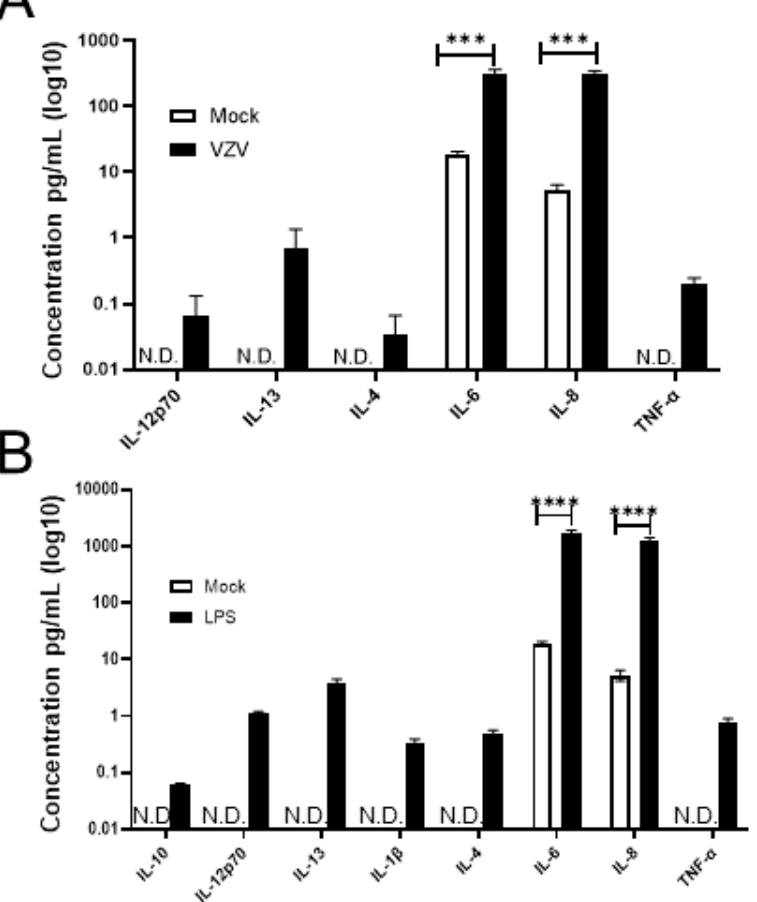
Figure 3. VZV-infected quiescent human adrenal cortical cells (qHAdCCs) secrete proinflammatory cytokines. ( A ) At 3 days post-infection, conditioned supernatant from mock- and VZV-infected cells were analyzed for proinflammatory cytokines IL-1 β , IL-2, IL-4, IL-6, IL-8, IL-10, IL12p70, IL-13, IFN- γ , and TNF- α by a multiplex assay. Compared to mock-infected cells, VZV-infected cells had significantly increased levels of IL-6 ( p = 0.0005) and IL-8 ( p = 0.0002). IL-12p70, IL-13, IL-4, and TNF- α were detected in supernatant from VZV-infected cells, but not from mock-infected cells. ( B ) As a positive control to demonstrate that qHAdCCs have the capacity to secrete proinflammatory cytokines, qHAdCCs were treated with lipopolysaccharide (LPS) for 24 h. Compared to Mock qHAdCCs, LPS-treated cells showed significantly elevated levels of IL-6 ( p < 0.0001) and IL-8 ( p < 0.0001); IL-10, IL-12p70, IL-13, IL-1 β , IL-4, and TNF- α were also present in LPS-treated cell supernatant but not detected in mock. N.D. = not detected. **** = p < 0.0001, *** = p <